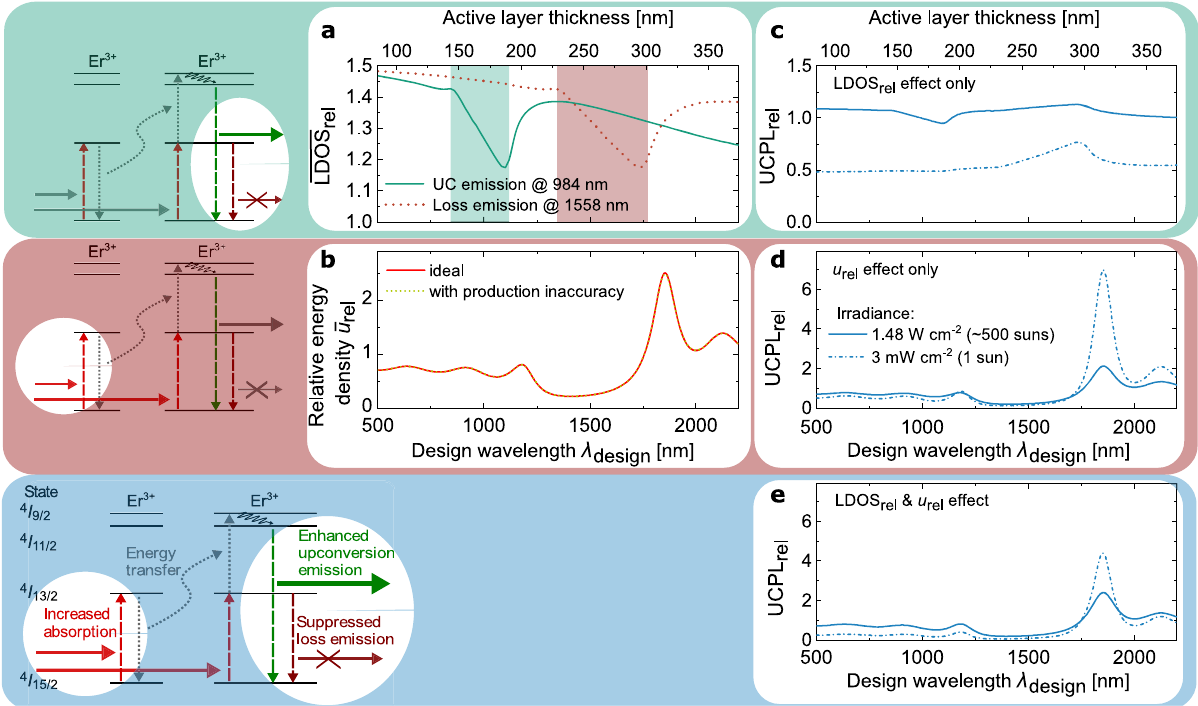
Fig. 3 Photonic effects on upconversion (UC) as a function of the design wavelength λ design . a Average relative local density of optical states (LDOS rel ) in the active layers of the Bragg structure for the main UC emission and main loss emission. b Average relative energy density ( (cid:1) u rel ) in the active layers of the Bragg structure for an excitation at 1523 nm for an ideal Bragg structure and the fabricated structure including measured production inaccuracies. c – e Relative UC photoluminescence (UCPL rel ) at 3 mW cm − 2 (1 sun), as well as at 1.48 W cm − 2 (~500 suns) irradiance as in experiment, only taking into account the LDOS effect ( c ), the effect of the relative energy density ( d ), and both effects ( e ). Under 1 sun illumination, the irradiance in the absorption range of the upconverter Er 3 + (1450 nm – 1600 nm) is 3 mW cm − 2 (ref. 53